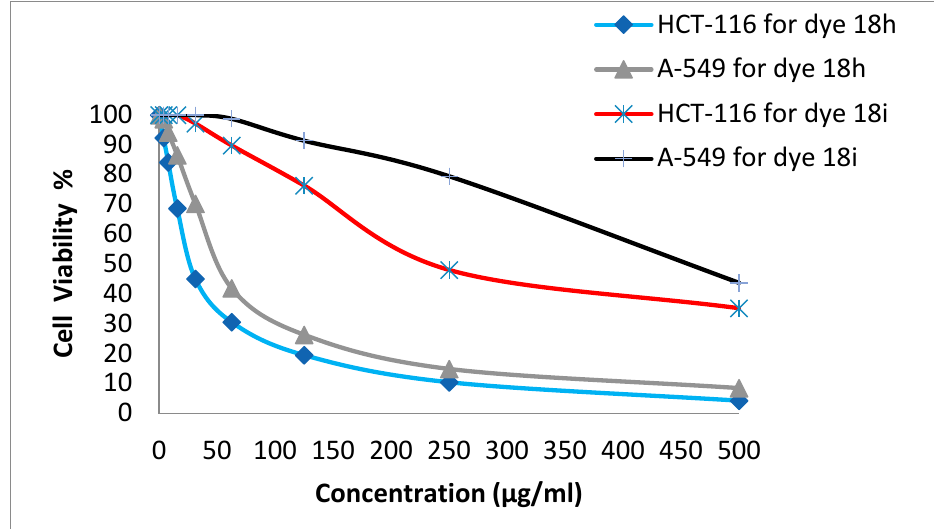
Figure 7. Antitumor (HCT-116) and (A-549) activities of disperse dyes 18h and 18i.